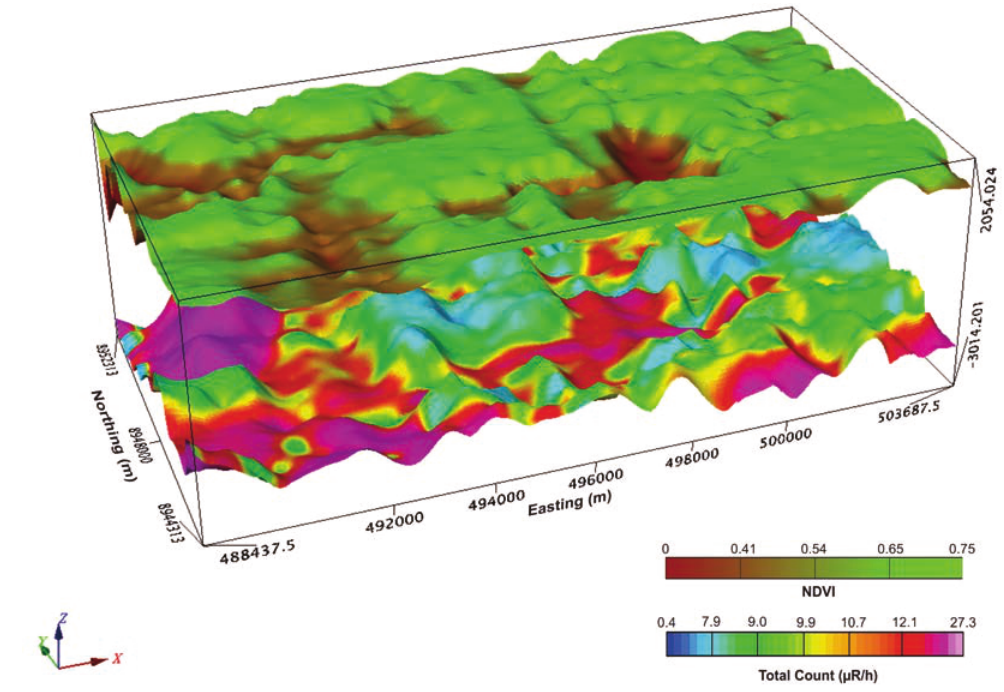
Figure 6 - Three-dimensional comparison of NDVI and TC maps. The vertical scale of the TC map is based on airborne DEM values